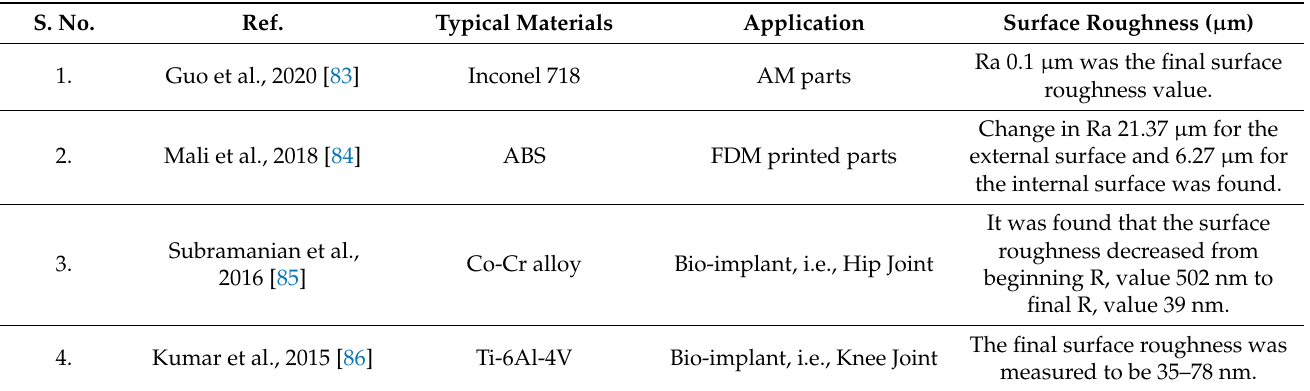
Table 3. Literature summary of performance analysis of the AFM process regarding their process parameters.